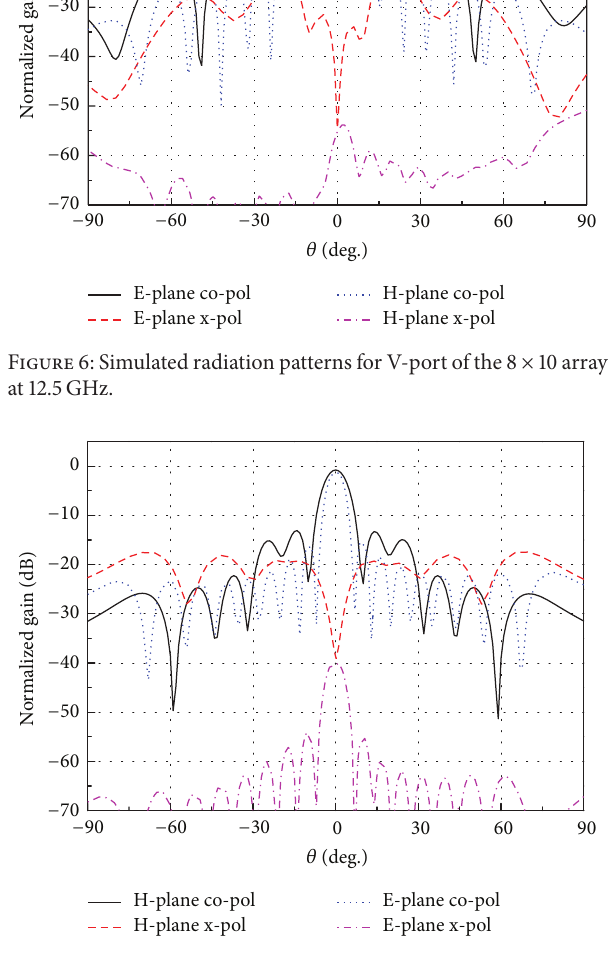
Figure 7: Simulated radiation patterns for H-port of the 8 × 10 array at 14.25